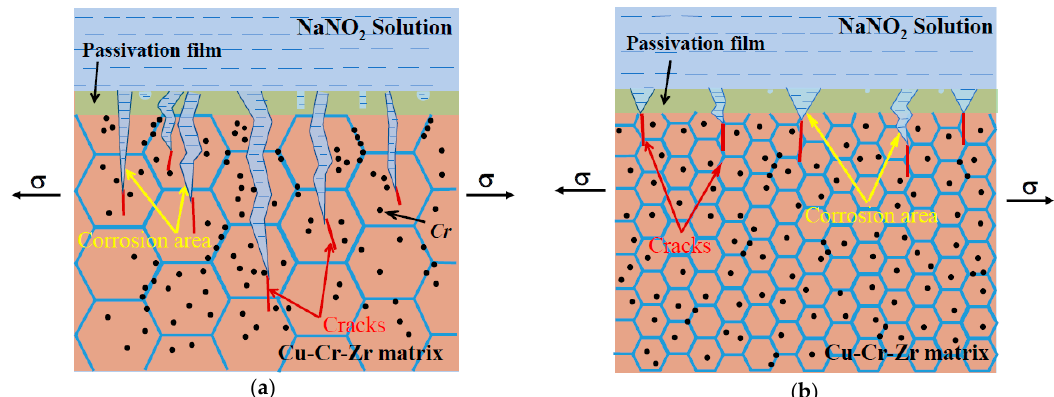
Figure 6. Corrosion mechanism diagram in NaNO 2 solution: ( a ) CG Cu-Cr-Zr alloy and ( b ) UFG Cu- Cu-Cr-Zr